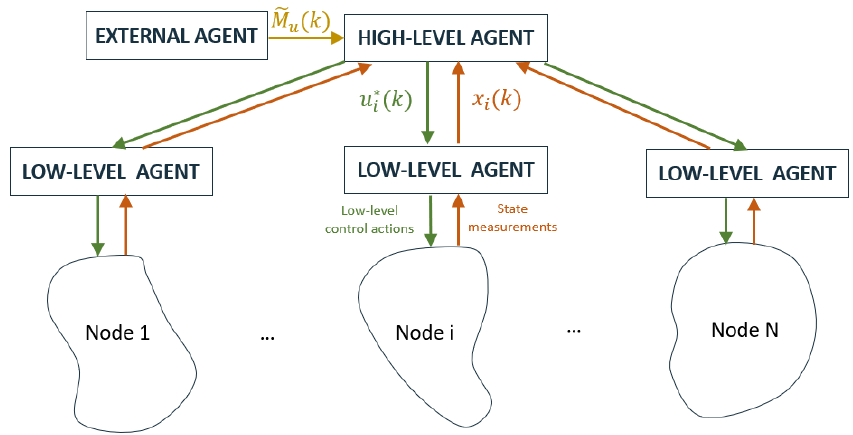
Figure 3. Generic centralised MPC diagram.